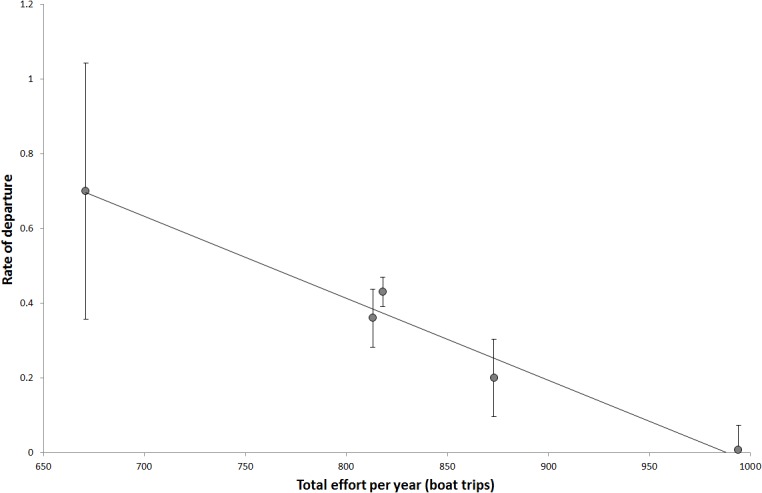
The rate of departure as a function of total effort ± standard errors indicating that the rate of departure from the aggregation slows with increasing numbers of trips.Rate of departure = -0.0022effort + 2.17, R2 = 0.97, p = 0.002.